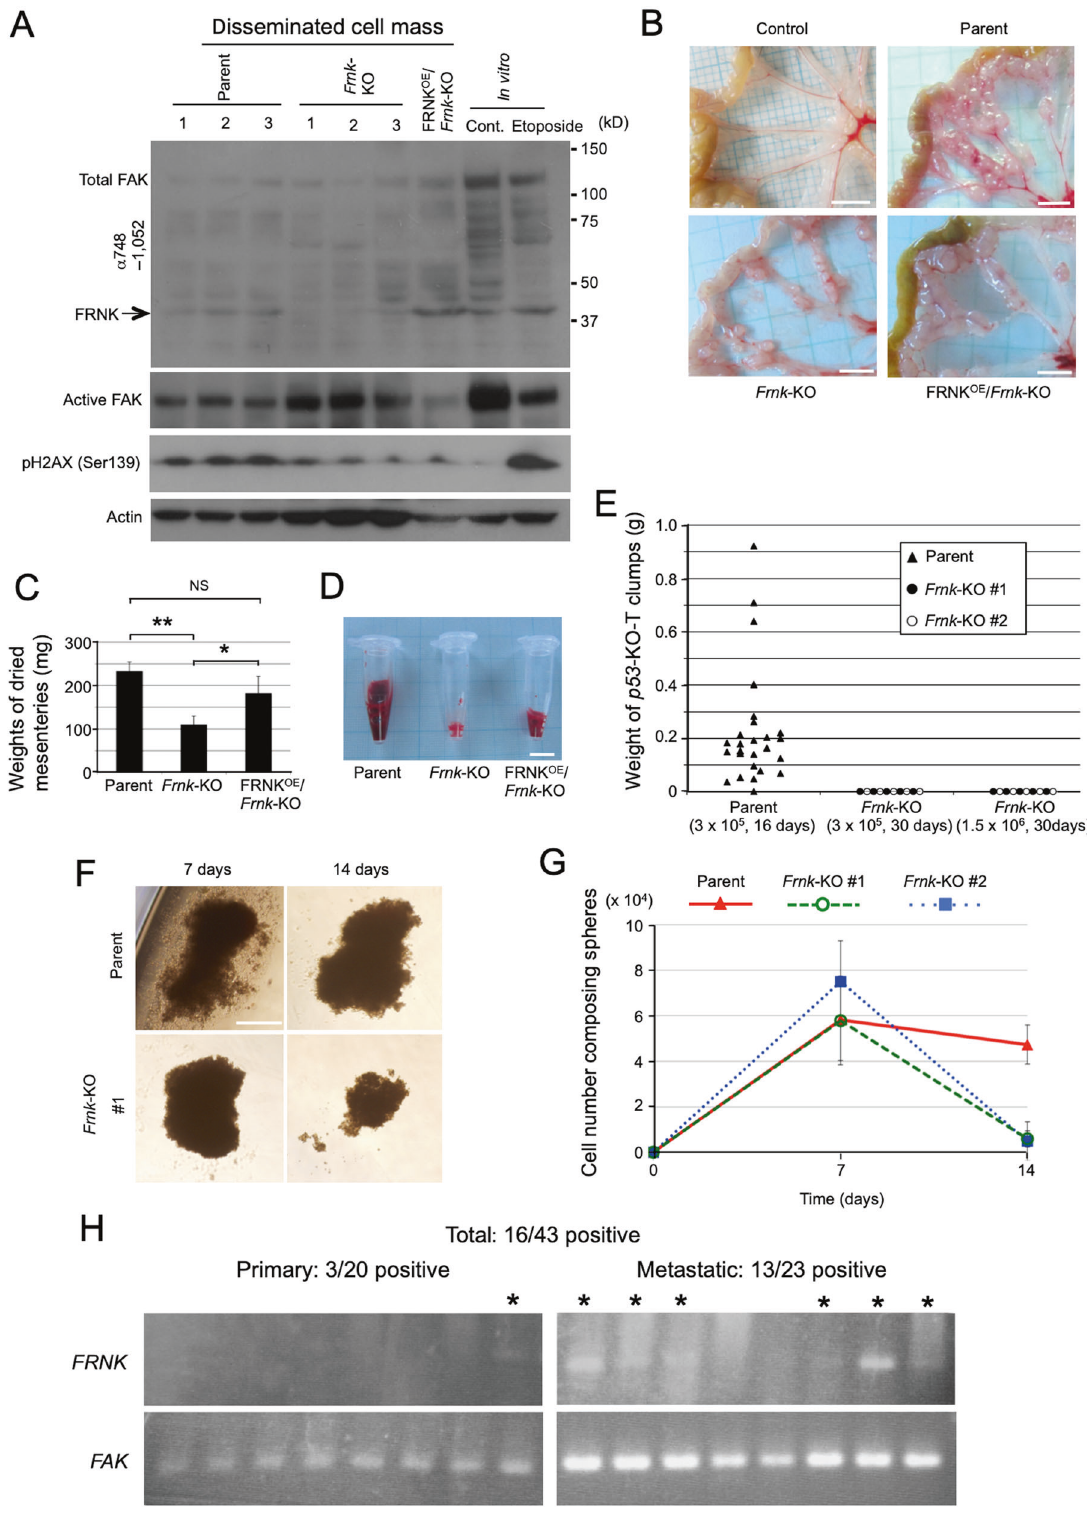
(Supplementary Fig. S7G; arrows and bracket). Immunoblot analysis con fi rmed the increase in active caspase 3 in the irradiated stomachs of Frnk -KO mice compared with those of WT mice (Supplementary Fig. S7H). Cumulatively, these results demonstrate that FRNK is involved in genotoxic stress tolerance